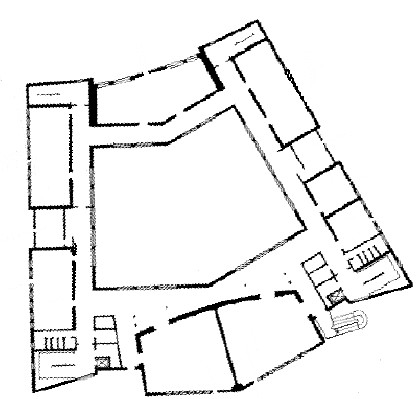
Figure 1. Case study: building of the University of Padua.